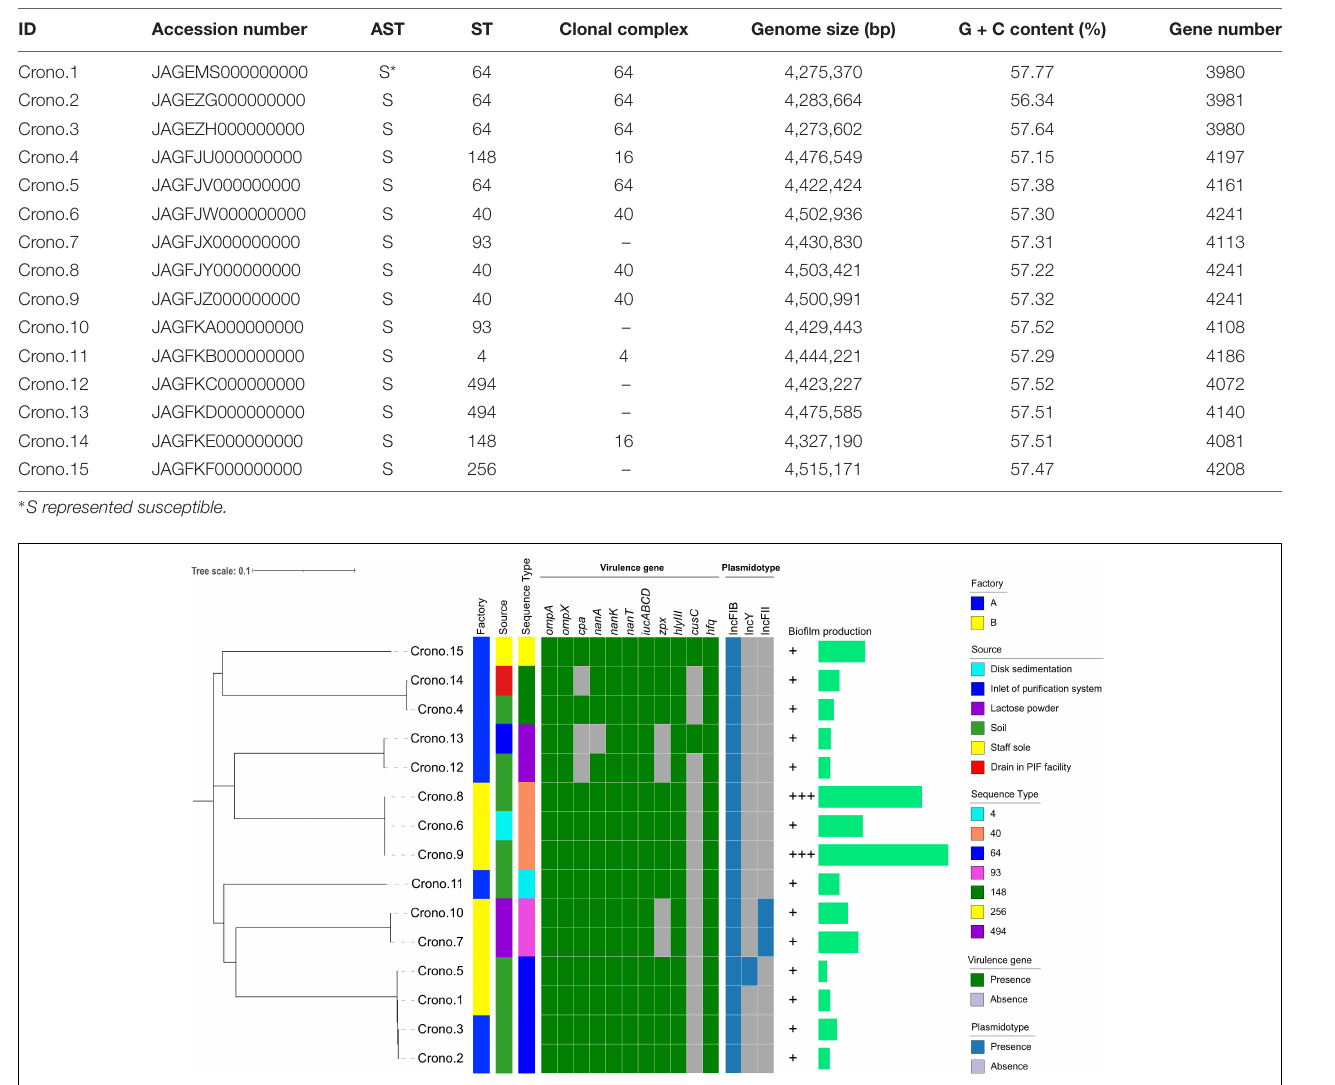
TABLE 1 | Information of 15 C. sakazakii isolates.